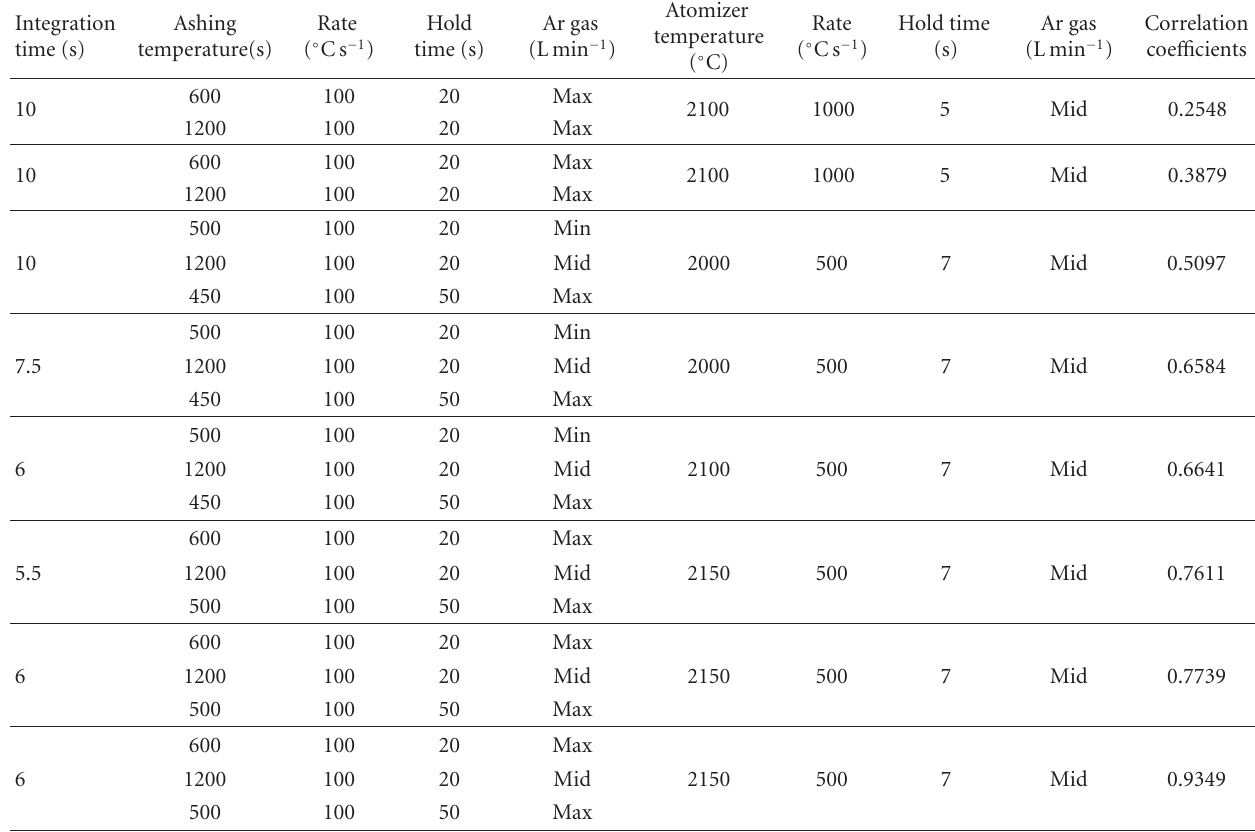
Table 1: Optimization of the furnace program for the analysis of coal fly ash (solid sampling system).